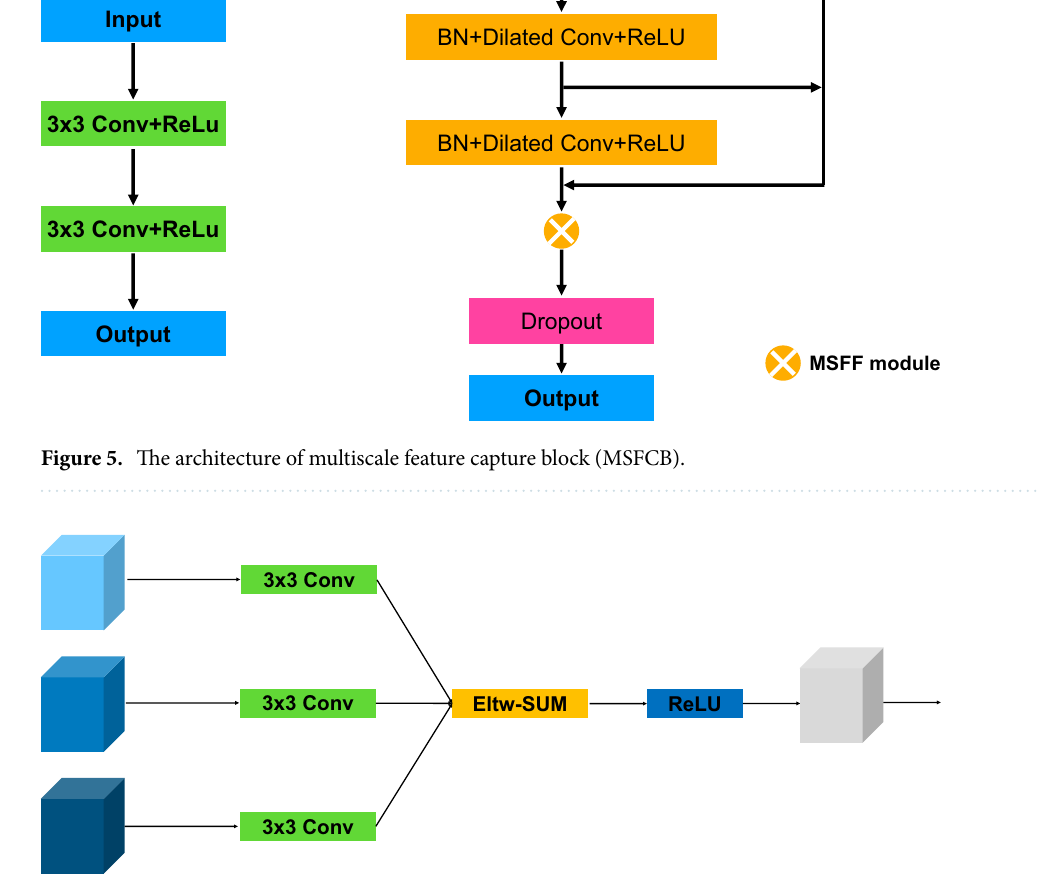
Figure 6. Illustration of the multiscale feature fusion (MSFF) module. Eltw-SUM refers to point-to-point addition of feature maps containing different levels of